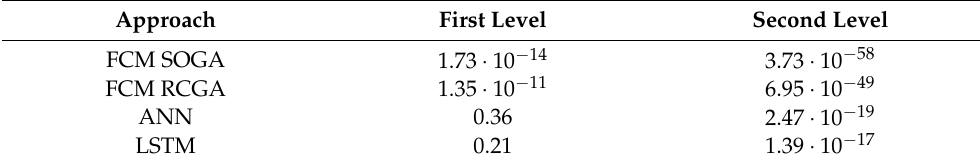
Table 4. p -values achieved by the paired-sample Wilcoxon signed-rank test comparing the forecasting error FE of the nested structure (first level, second level) and the remaining